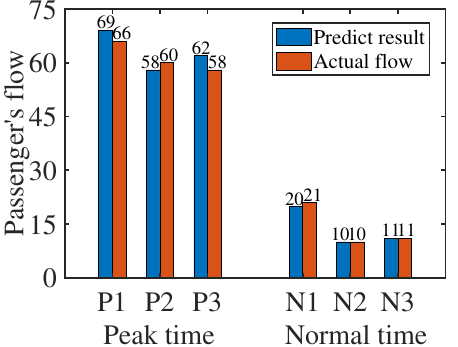
Figure 16. Passenger flow rate statistics in different